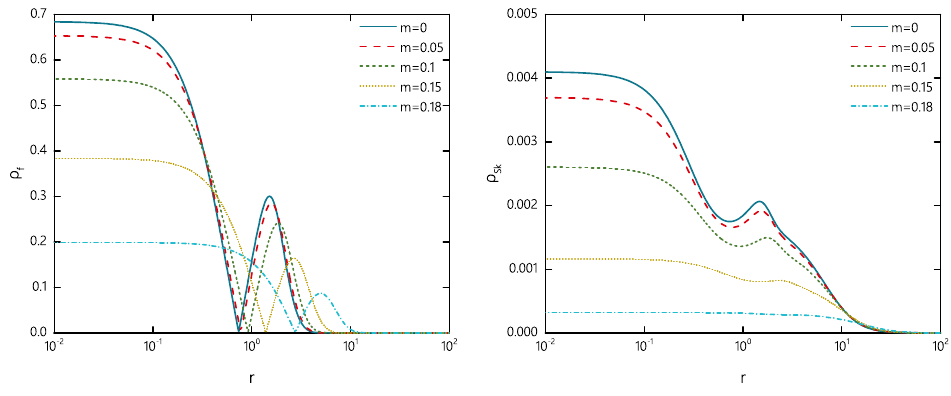
Figure 10 . Distributions of the fermionic density of the localized mode A 1 (left plot) and the topological density of the Skyrmion coupled to this mode (right plot) as functions of the radial coordinate r for some set of values of mass of fermions m at g = 100 and κ 0 = 0. Variation of the fermion mass parameter m also affects the structure of the